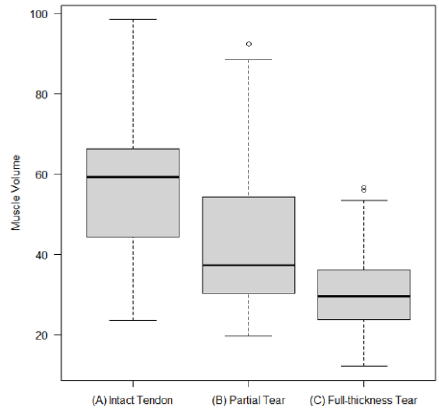
Figure 4. Boxplots showing minimum, first quartile, median, third quartile, and maximum for software-determined muscle volumes in the ( A ) intact SSP tendon subgroup (mean volume 56.9 cm 3 ), ( B ) partial SSP tendon tear subgroup (mean volume 43.6 cm 3 ), and ( C ) full-thickness SSP tendon tear subgroup (mean volume 31.1 cm 3 ; p < 0.001).